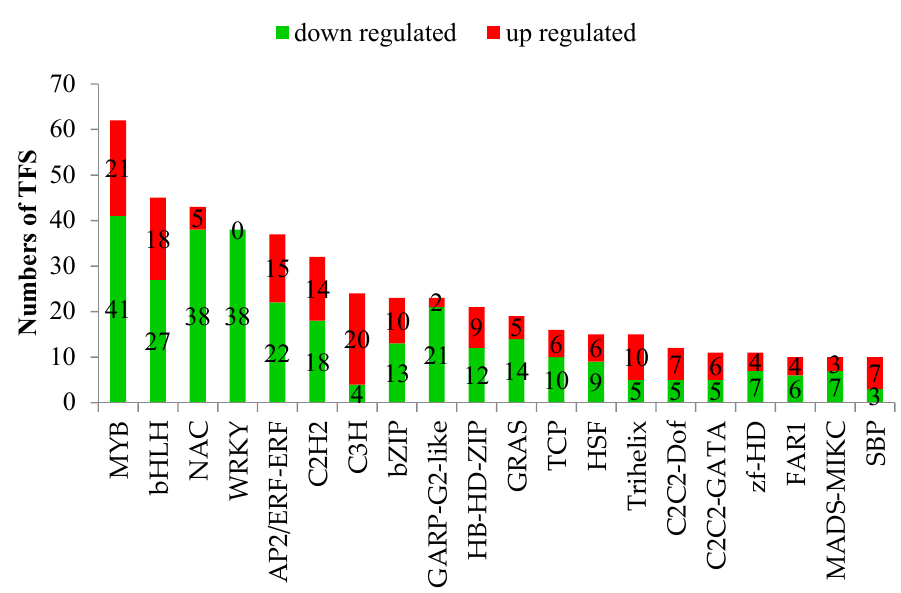
Figure 7. Number of TFs in the top 20 transcription factor families. The x -axis represents the top 20 TFs, and the y -axis represents the number of TFs. The numbers on the red bar indicate the number of upregulated TFs, and the numbers on the green bar indicate the number of downregulated TFs.